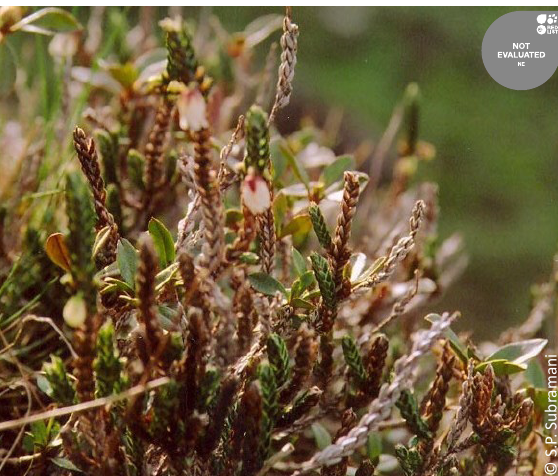
Image 38. Cassiope fastigiata (Wall.) D.